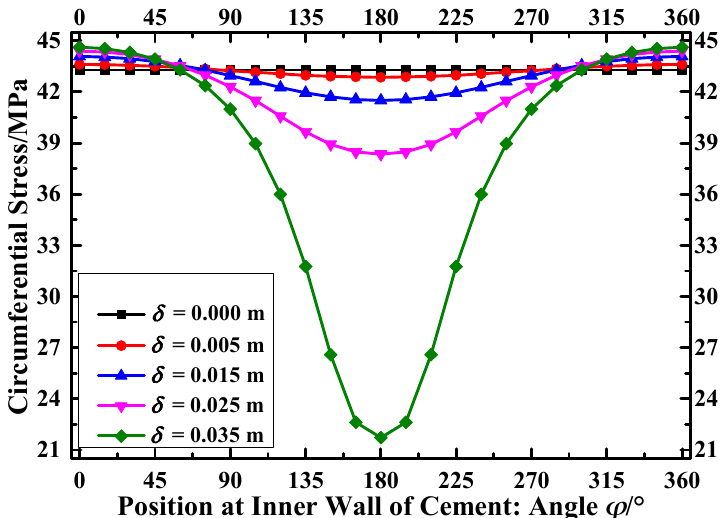
Figure 8. Variation of circumferential stress with azimuth angle ϕ for different eccentricity magnitudes .